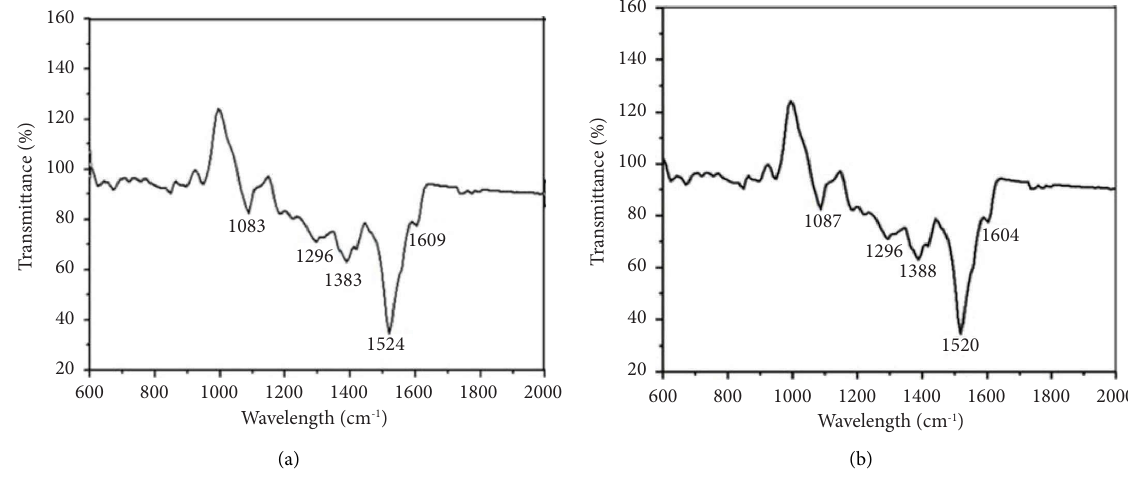
Figure 1: FT-IR spectra of biosynthesis AgNPs using Aloe vera leaf extract in 6hours (a) and 12hours (b) at 100 °